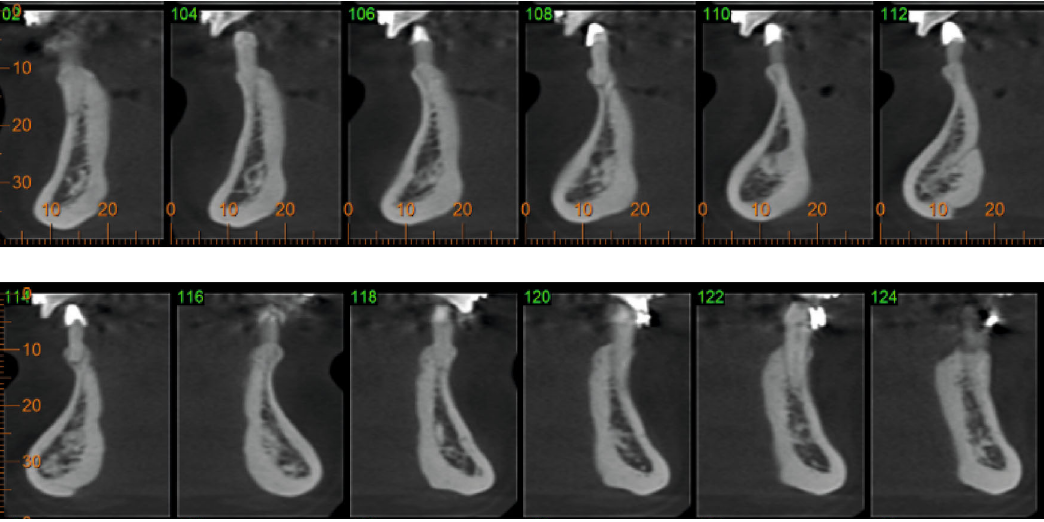
Figure 2: Preoperatory tomography of the anterior mandible